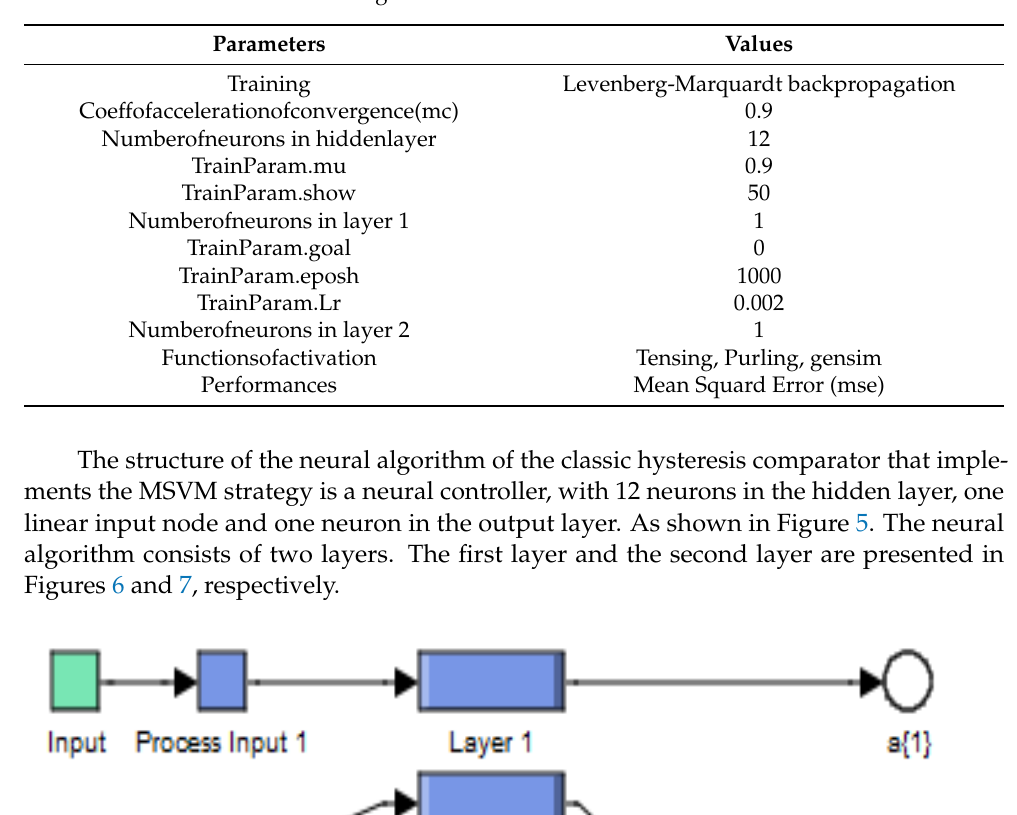
Table 1. Parameters of the neural algorithm.